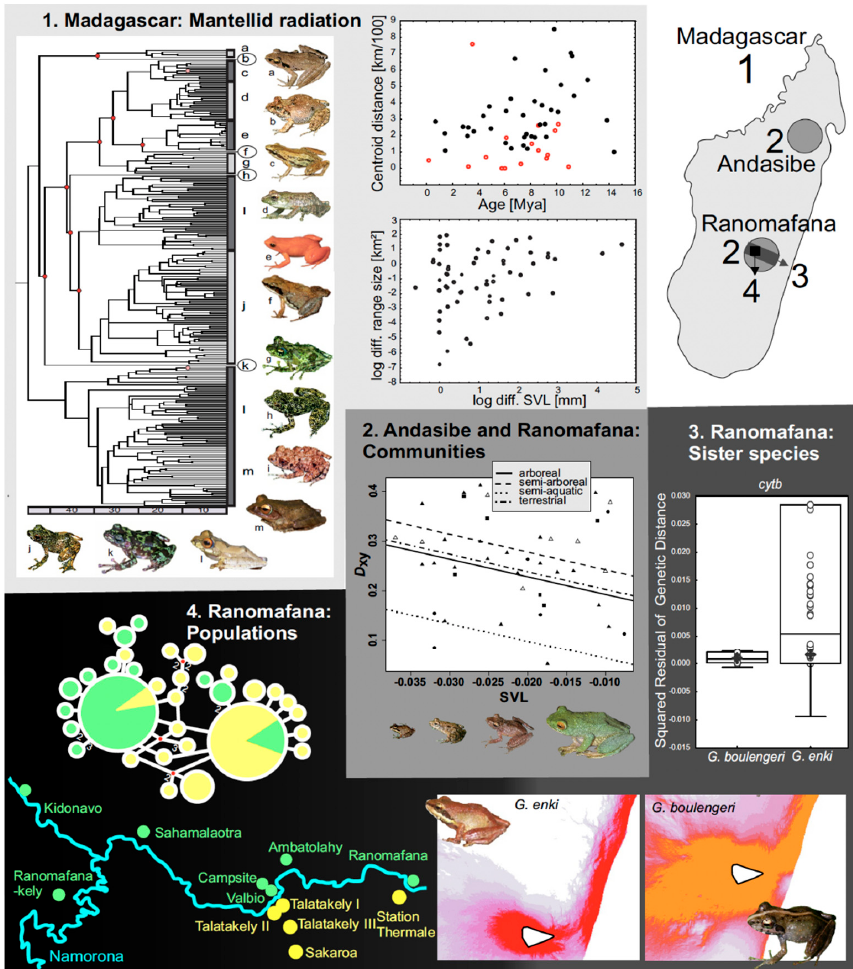
Figure 4. The importance of body size on amphibian diversification, from radiation to population. In Madagascar, the influence of body size on patterns and processes of evolution has been studied on several levels of the radiation, including (1) the complete radiation of mantellid frogs. Genera are abbreviated as follows: a, Aglyptodactylus ; b, Laliostoma ; c, Blommersia ; d, Guibemantis ; e, Mantella ; f, Wakea ; g, Spinomantis ; h, Boehmantis ; i, Gephyromantis ; j, Mantidactylus ; k, Tsingymantis ; l, Boophis. SVL_ - - Snout-vent length (2) The community level, comparing communities between sites of high diversity, Andasibe and Ranomafana, (3) A pair of mantellid sister species and (4) populations of one of these species. (1) Mantellid frogs of Madagascar constitute a species-rich amphibian radiation with high diversity of ecology and phenotype (tree). Young pairs of sister species are found in closer spatial proximity than older sister species pairs (top scatterplot), and sister species with different range sizes also differ in their body sizes (bottom scatterplot). (2) Mantellid divergence between sister species of two spatially separated communities is higher for smaller species indicating their more limited ability to disperse. (3) In a pair of ecologically similar mantellid sister species, Gephyromantis enki (smaller) and G. boulengeri (larger), the smaller species shows higher residual genetic variance across the same landscape than the larger species (box plot). Landscape resistance is lower for the larger species (inset maps; strength of landscape resistance is ranging from low - orange to high - red). (4) The population diversification for the small G. enki is influenced by barriers to dispersal such as the Namorona River (blue line) where localities on opposite sides of the river (yellow/green dots) are separated by a mutation in cytochrome b (indicated by the haplotype network with localities in corresponding colors). Figure references: Wollenberg et al., 2011 [34]; Pabijan et al., 2012 [348]; Wollenberg Valero, 2015 [199].